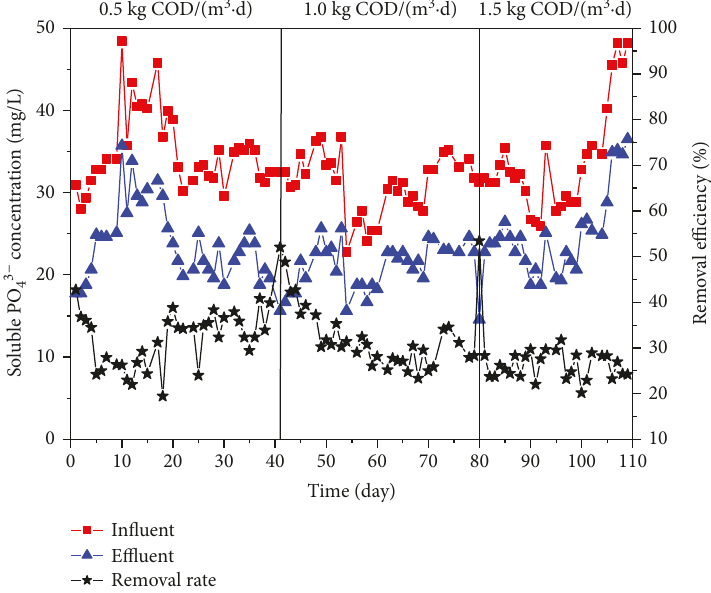
Figure 5: PO 43 − concentration variations in in fl uent and e ffl